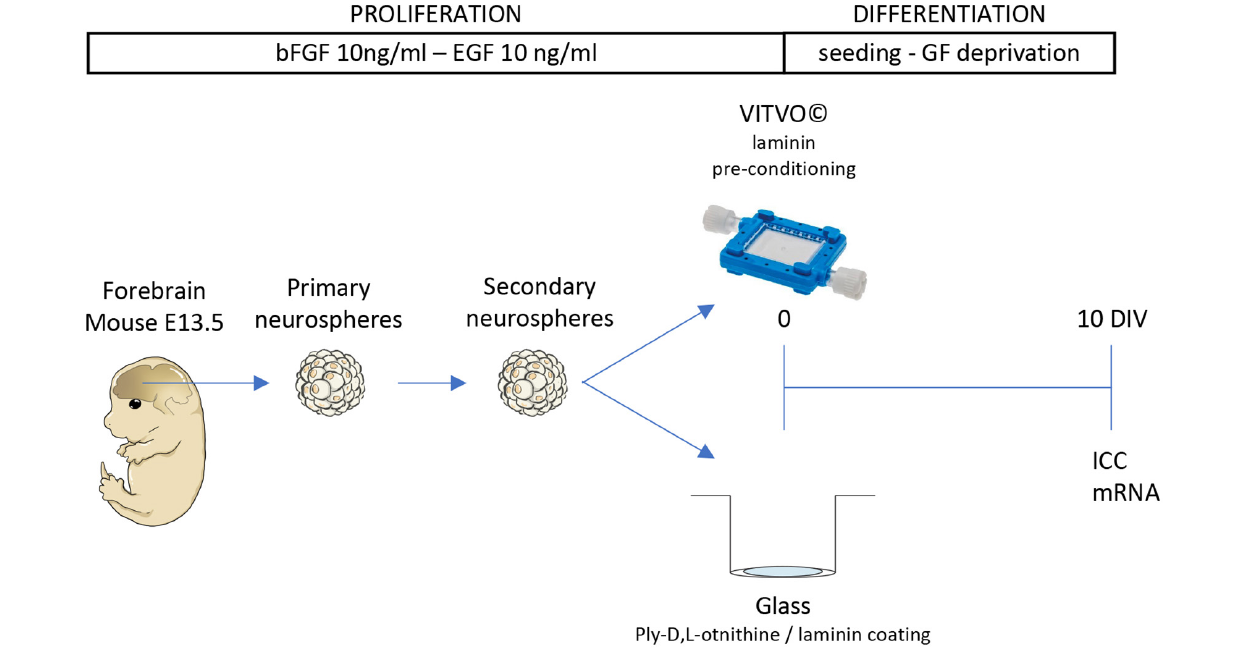
Frontiers in Cell and Developmental Biology |